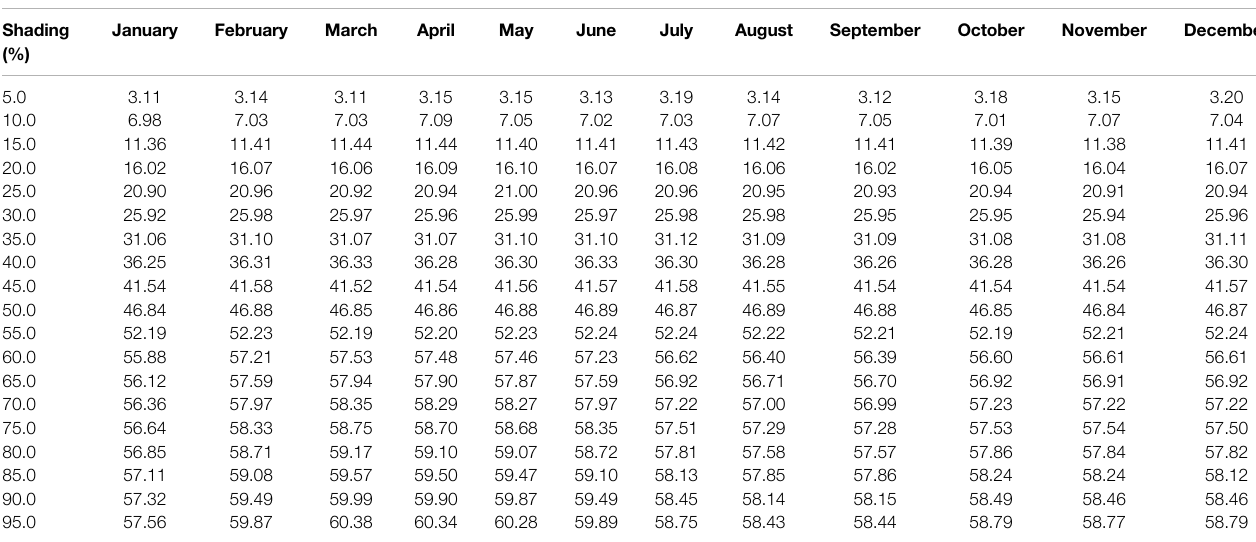
TABLE 8 | Monthly power losses (%). Shading